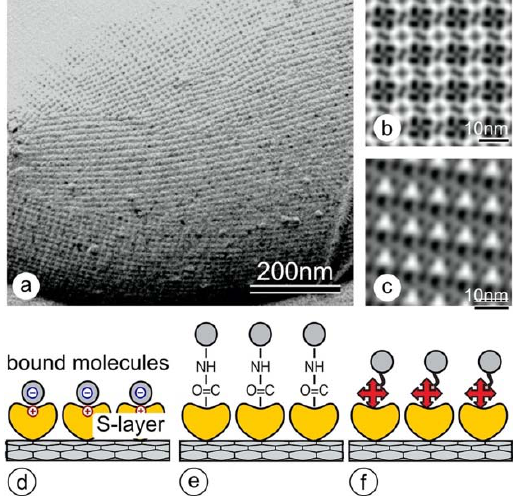
Figure 1. ( a ) TEM micrograph of a freeze-etched and metal shadowed preparation of the cell surface of Lysinibacillus sphaericus CCM 2177. The S-layer, which is the outermost cell wall component, shows a square lattice symmetry. The numerous lattice defects are necessary for the S-layer lattice to cover the curved cell pole. In the 2D-image reconstructions, the square (p4) lattice symmetry of the SbpA ( b ) and the oblique (p1) of the SbsB ( c ) become clearly visible. The protein is bright, while the staining in the pores and wells is dark. ( d – f ) Schematic drawings of S-layer protein arrays used for binding (bio)molecules by ( d ) electrostatic interactions, ( e ) surface chemical groups (e.g., after carbodiimide activation of carboxyl groups), or ( f ) functional domains in S-layer fusion proteins (e.g., by making use of the streptavidin-biotin interaction).